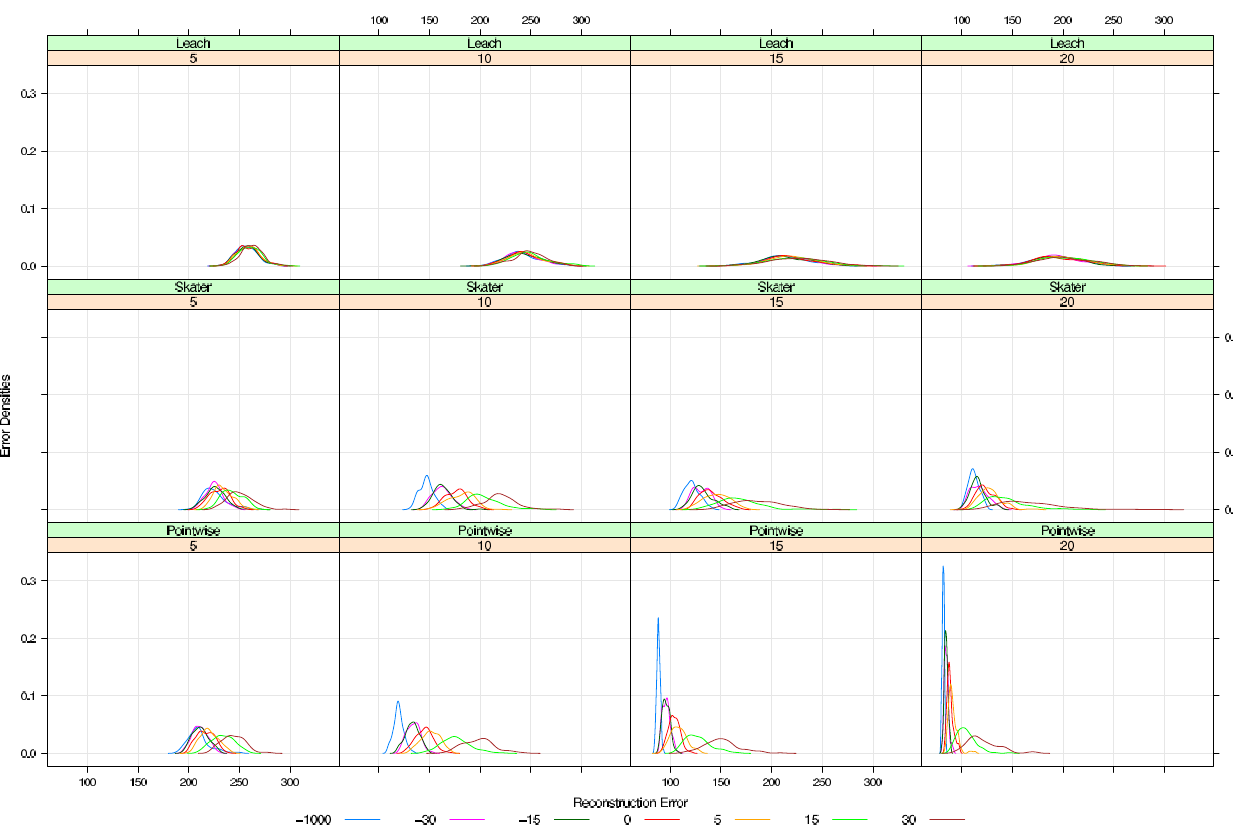
Figure 7. Reconstruction errors: three clustering/aggregation procedures (LEACH, SKATER and Pointwise, top, middle and bottom lines), four granularities (scales 5 , 10 , 15 , 20 , first to fourth column) and seven deployment point processes ( − 1000 , − 30 , − 15 , 0 , 5 , 15 and 30 in different